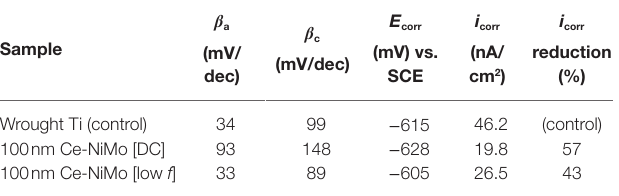
FIGURE 9 | PDP scans in electrochemical glass cells at the end of 3-day SRB TABLE 5 | Tafel parameters derived from PDP curves in Figure 9 .